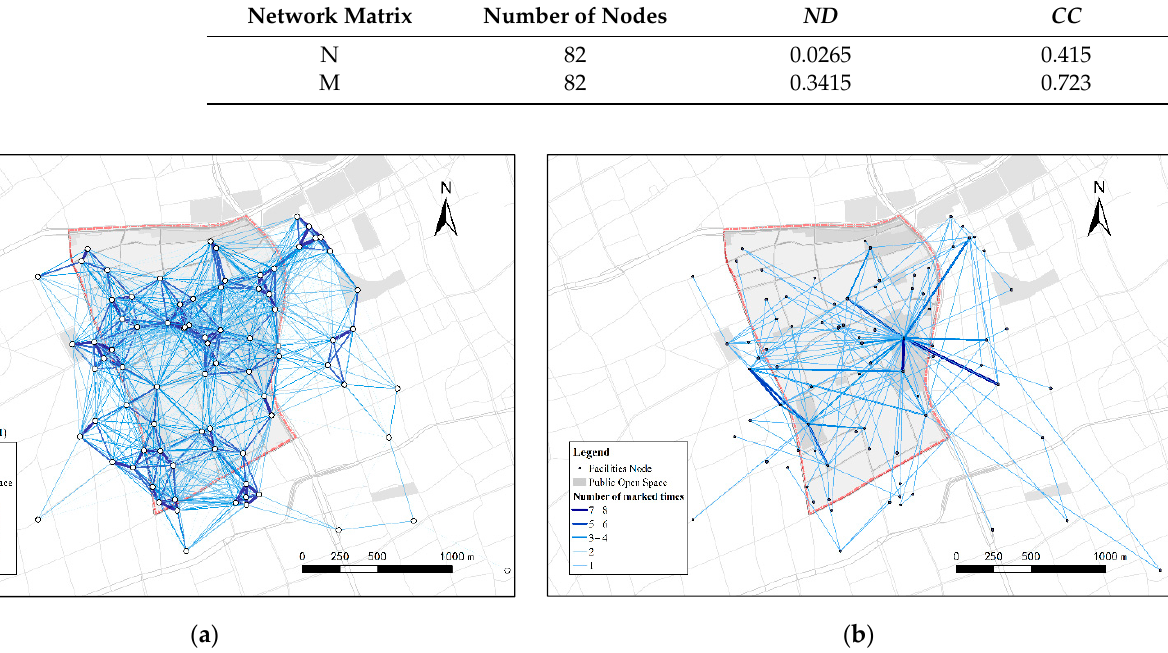
Figure 5. LS between nodes: ( a ) LS in the spatial network; ( b ) LS in the behaviour network.